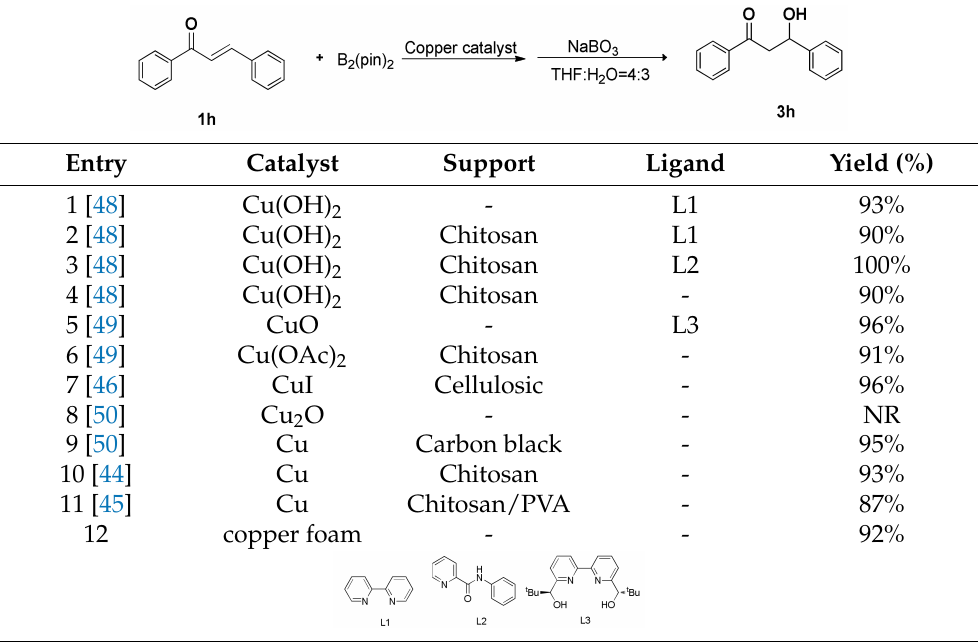
Table 4. Comparison of catalytic performance of copper foam catalysts with other copper